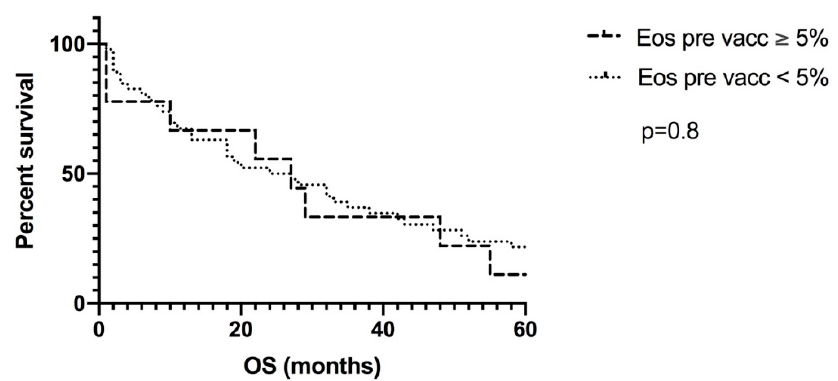
Figure 5. Analysis of the prevaccination eosinophil counts with OS. Prevaccination eosinophil levels did not associate with better outcome. There were nine patients with a preexisting eosinophilia of 5% or more, compared to 48 patients with preexisting values of less than 5%. Eos: eosinophilia; OS: overall survival.